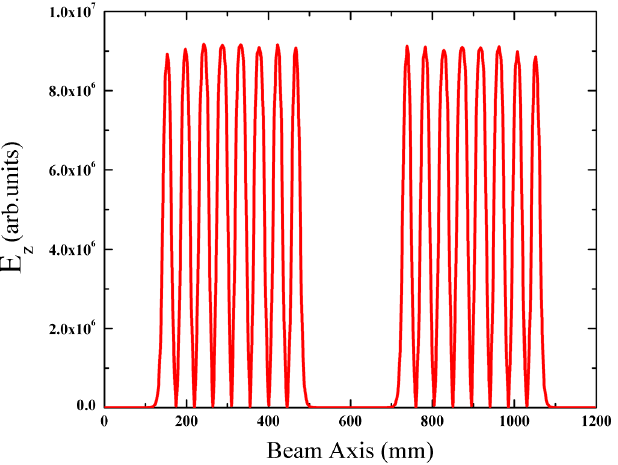
FIG. 25. The electric field distribution for the zero mode.